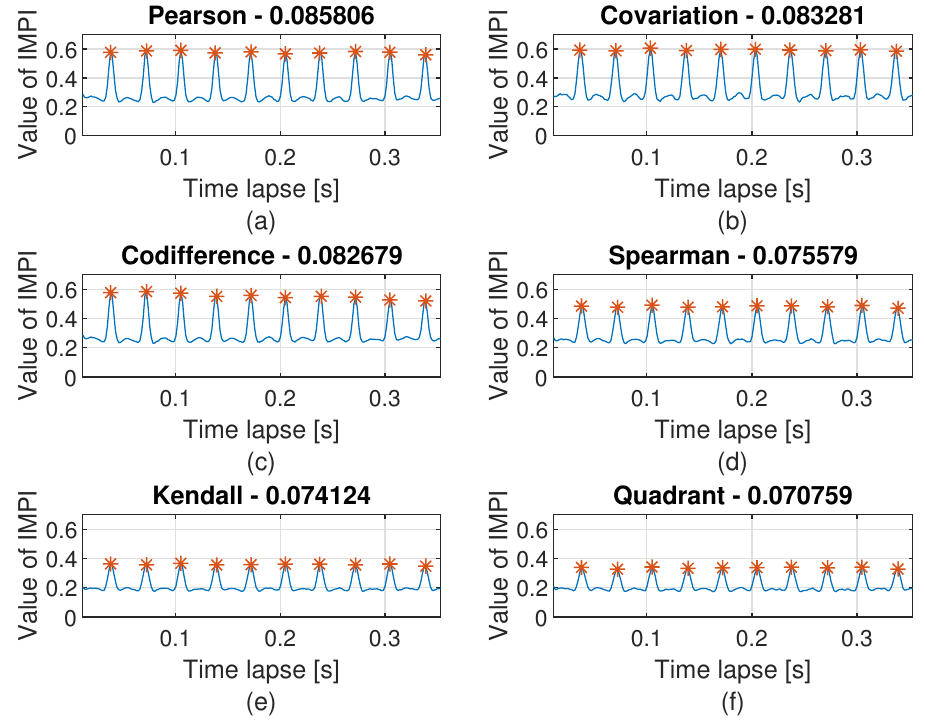
Figure 18. The results of IMPI calculated from auto-similarity maps only for IFB (2.5 kHz), in the case of different measures of dependence: ( a ) Pearson autocorrelation, ( b ) autocovariation, ( c ) autocodifference, ( d ) Spearman autocorrelation, ( e ) Kendall autocorrelation, ( f ) Quadrant autocorrelation—real vibration signal.